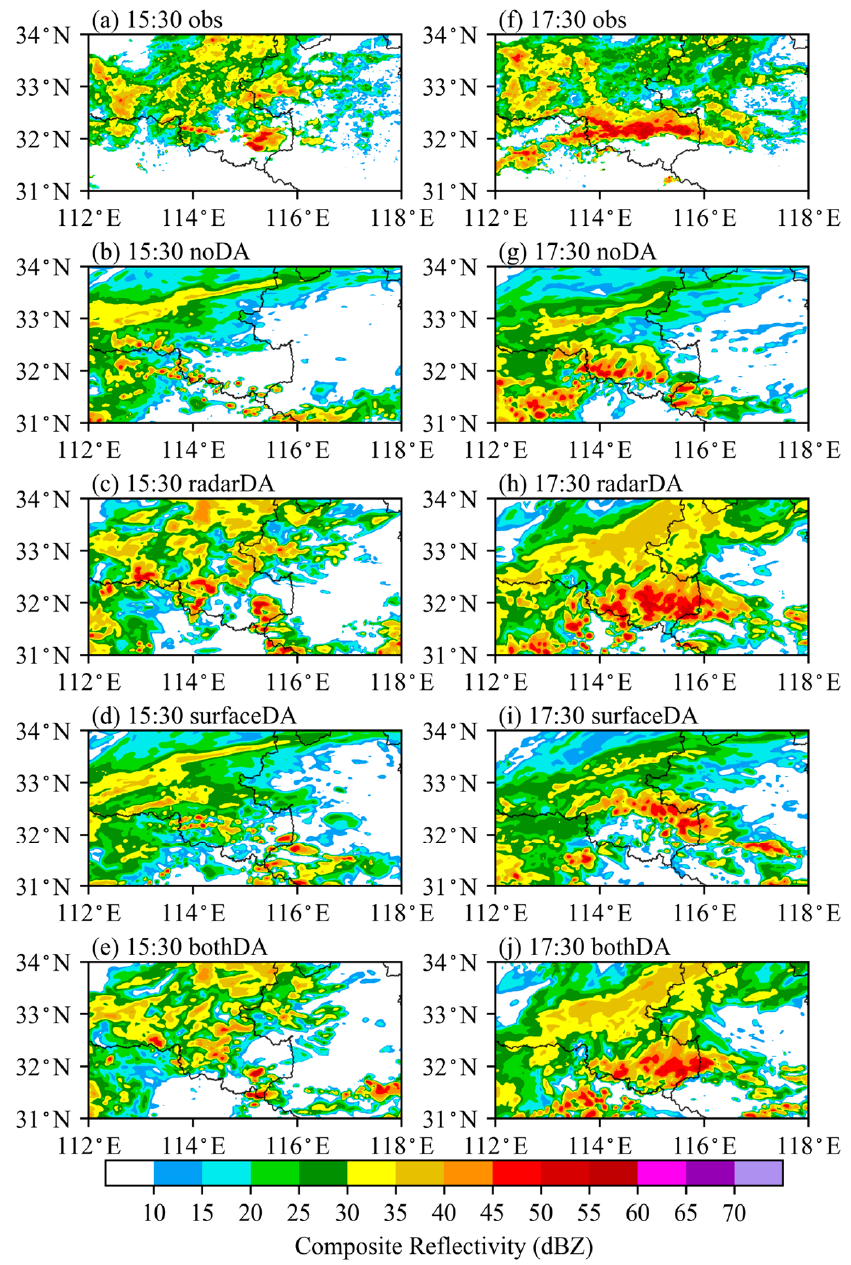
Figure 5. Radar composite reflectivity (shaded, units: dBZ) at ( a – e ) 1530 UTC and ( f – i ) 1730 UTC 11 July 2014 from the ( a , f ) observation, ( b , g ) noDA, ( c , h ) radarDA, ( d , i ) surfaceDA and ( e , j ) bothDA experiments.